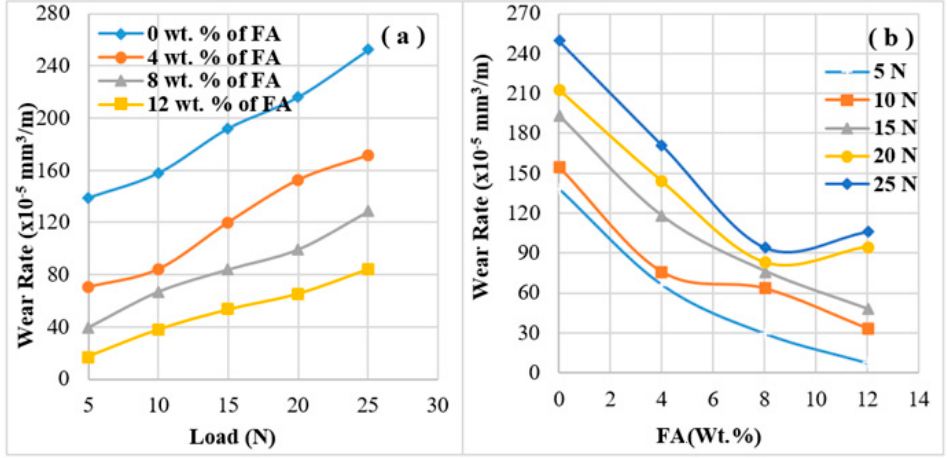
Figure 5. Wear rate of AA 6061 alloy-based MMCs as a function of ( a ) normal load applied; ( b ) wt.% FA [53].